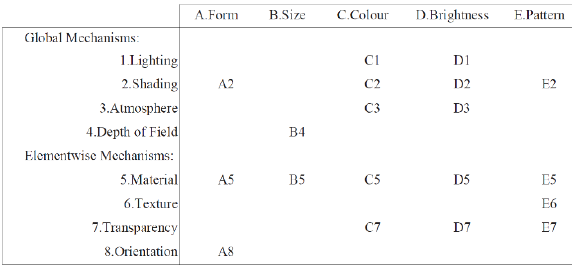
Figure 2 Graphical conflicts of 3D design mechanisms with graphical variables from Jobst et al.